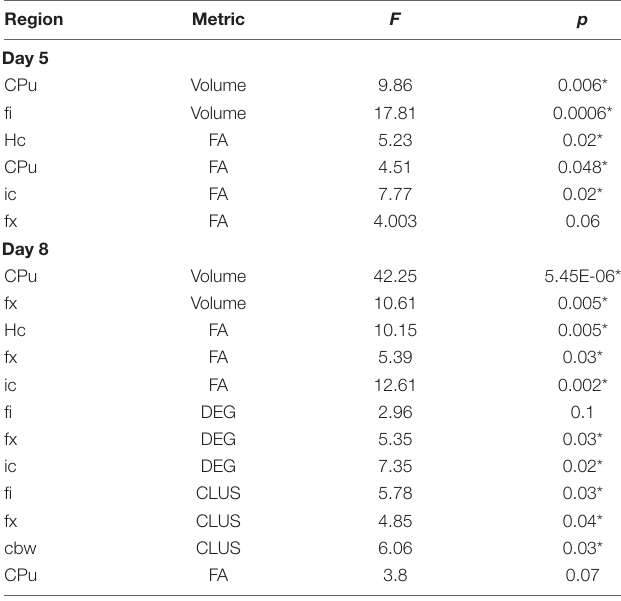
TABLE 3 | Main ANOVA results on the linear models predicting AWN based on MRI metrics.